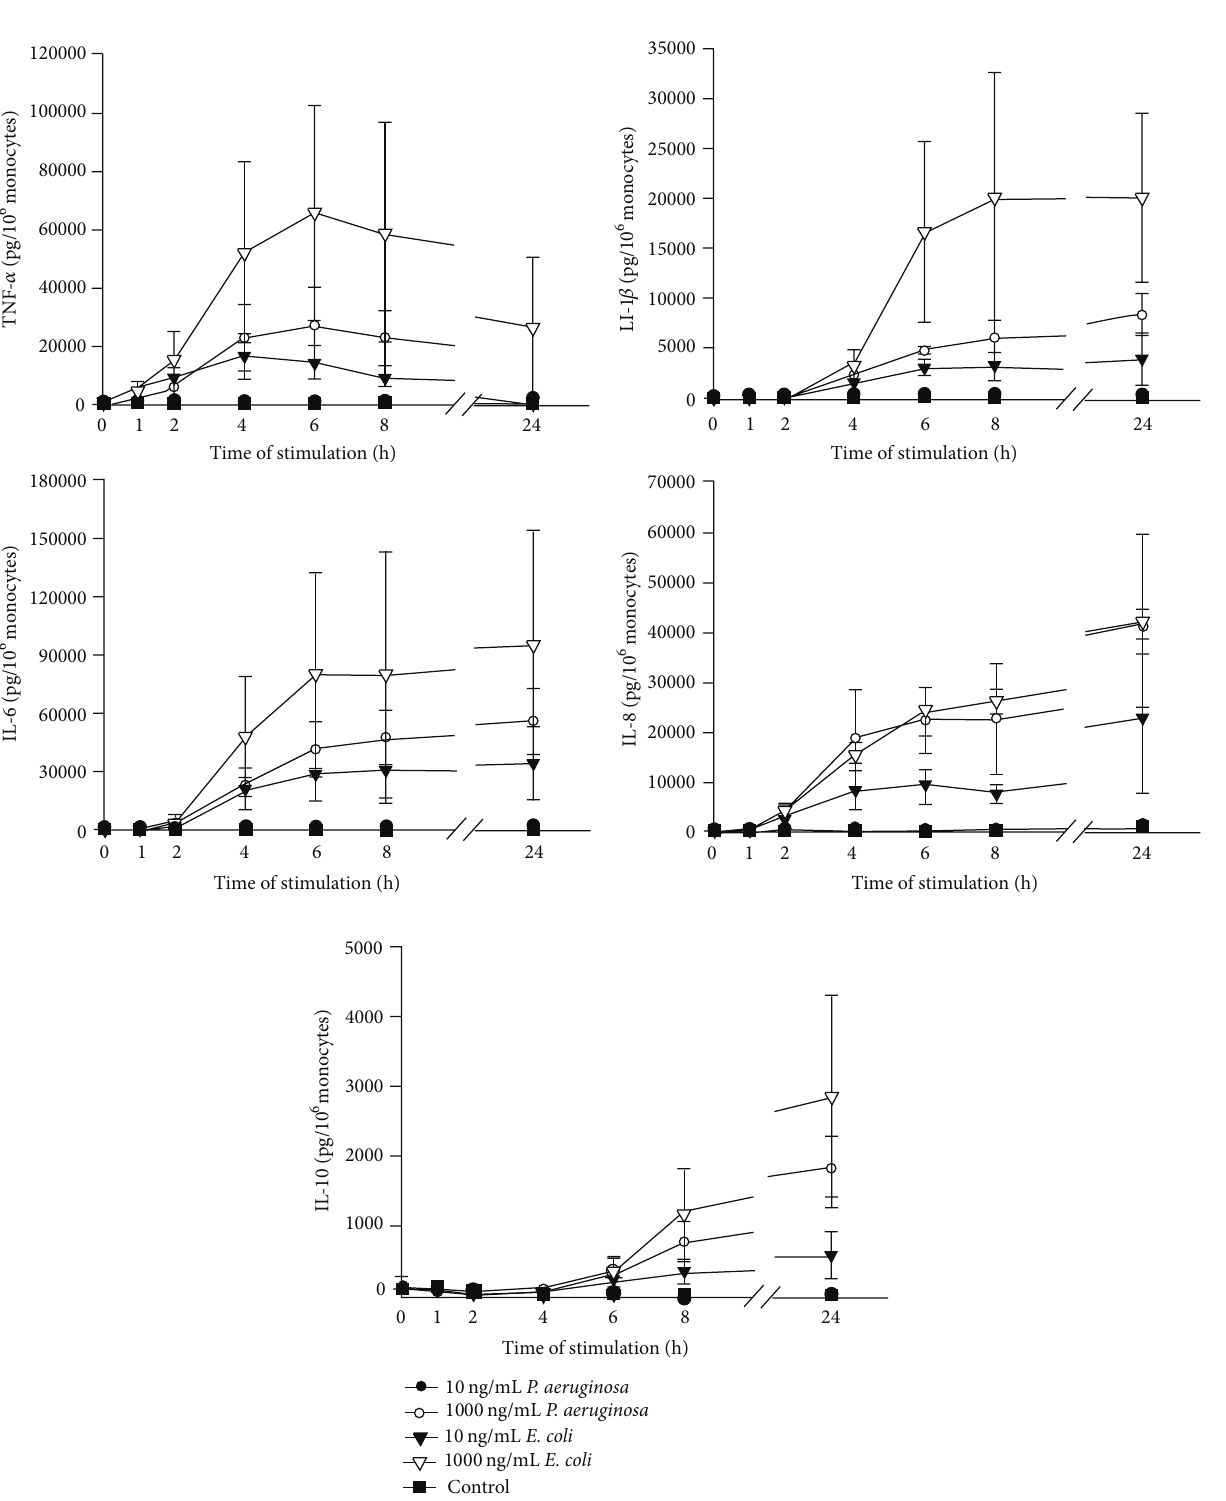
Figure 4: Effect of LPS on cytokine secretion from whole blood. Freshly drawn blood was stimulated with 10 or 1000 ng/mL LPS from P. aeruginosa or E. coli . Samples without LPS served as control. Concentrations of TNF- 𝛼 , IL-1 𝛽 , IL-6, IL-8, and IL-10 are expressed as mean ± SD ( 𝑛 = 3